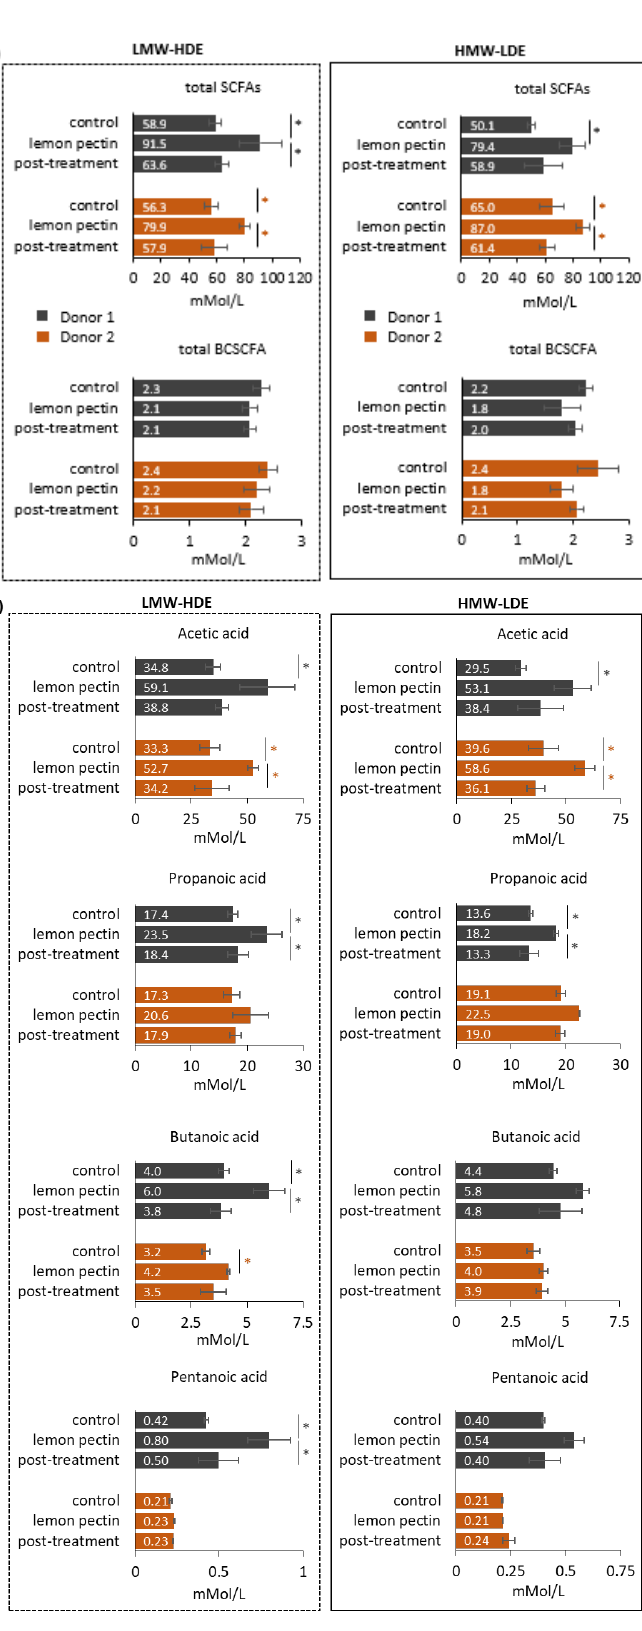
Figure 6. Levels of SCFAs produced during LMW-HDE and HMW-LDE lemon pectin treatment. Statistically significant changes are indicated in the figure with an asterisk (*) sign. ( A ) total SCFAs and total BCSCFAs; ( B ) Levels of individual SCFAs: acetic, propanoic, butanoic, and pentanoic